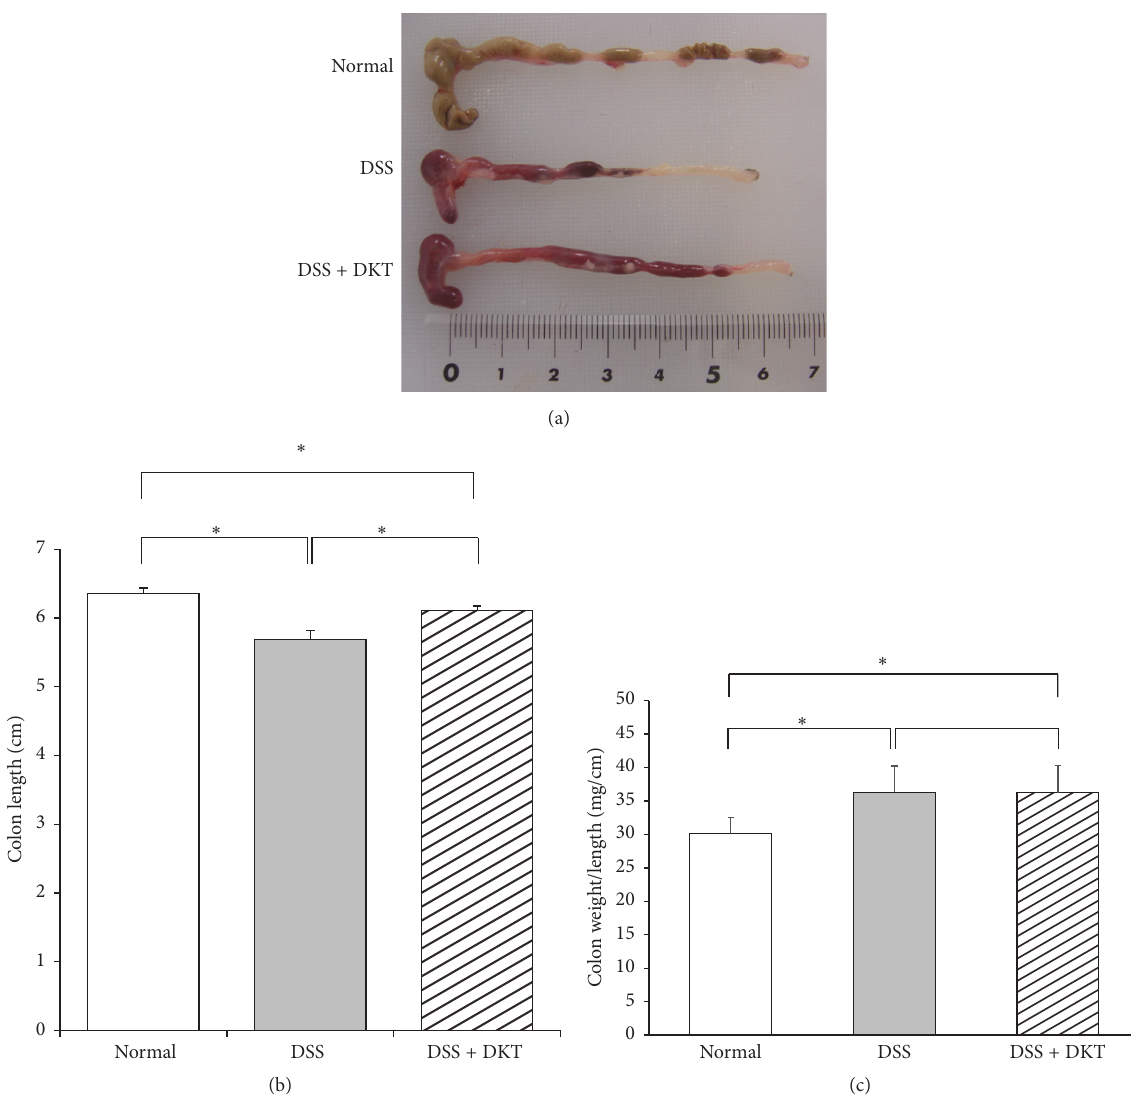
Figure 2: (a) Macroscopic appearance and (b) colon length of each study group. Normal group, untreated mice. Dextran sulfate sodium (DSS) group, mice provided with 5% DSS for 7 days. DSS + daikenchuto (DKT) group, mice provided with DKT in addition to DSS. 𝑛 = 10 mice (for normal, DSS, and DSS + DKT groups). (c) Colon relative weight (weight/length) of each study group. ∗ 𝑝 < 0.05 .